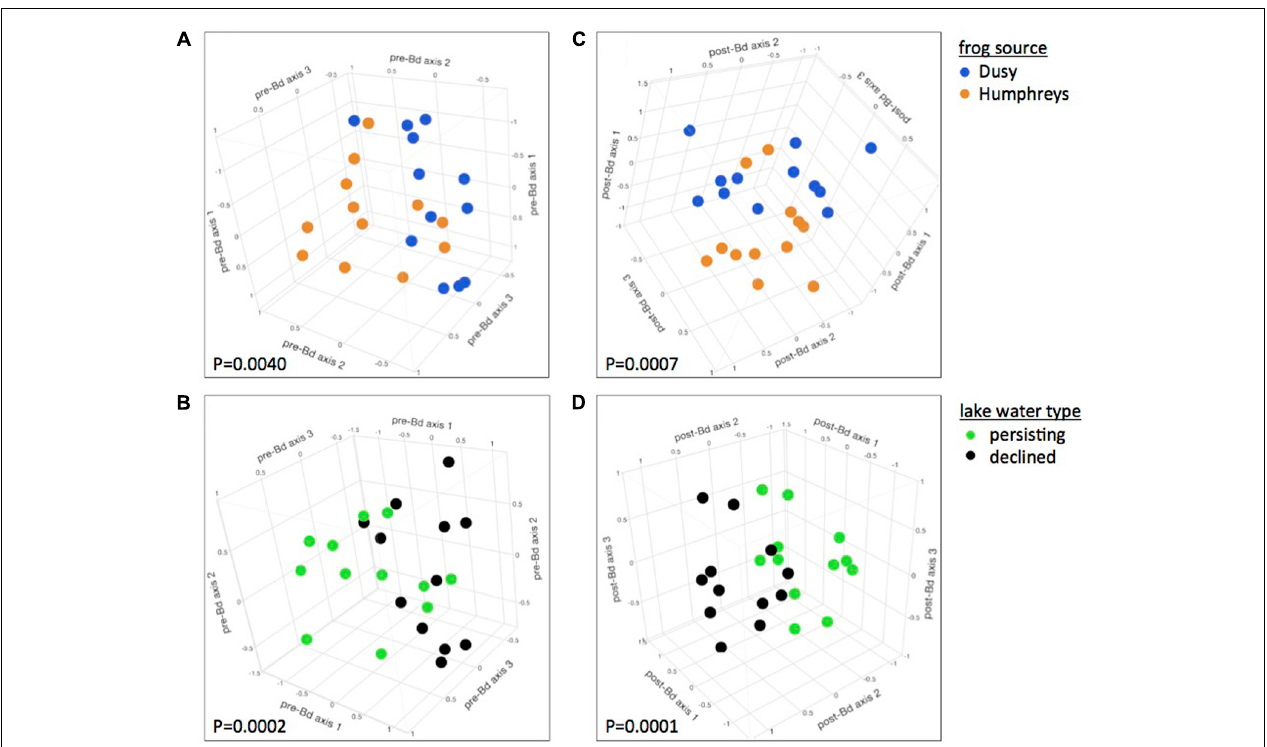
FIGURE 1 | Effects of host and aquatic environment on the skin microbiome. Skin bacterial communities were significantly different between frogs from the two source populations prior to Bd infection (A) and differences persisted after Bd infection (C) . Frogs housed in water from persistent and die-off field sites had different microbiomes, (B) and these differences persisted after Bd infection (D) . Plots are 3-dimensional NMDS ordinations of R. sierrae skin-associated bacterial communities, pooled by treatment, sampled on day 21 of the experiment (after 3 weeks of water treatments, and before Bd infection, left panels), and day 43 (21 days after Bd exposure, right panels). Plots are rotated to display treatment differences. Marker colors indicate Frog Source (top) or Lake Water Type (bottom). NMDS stress: (A,B) 0.06; (C,D)